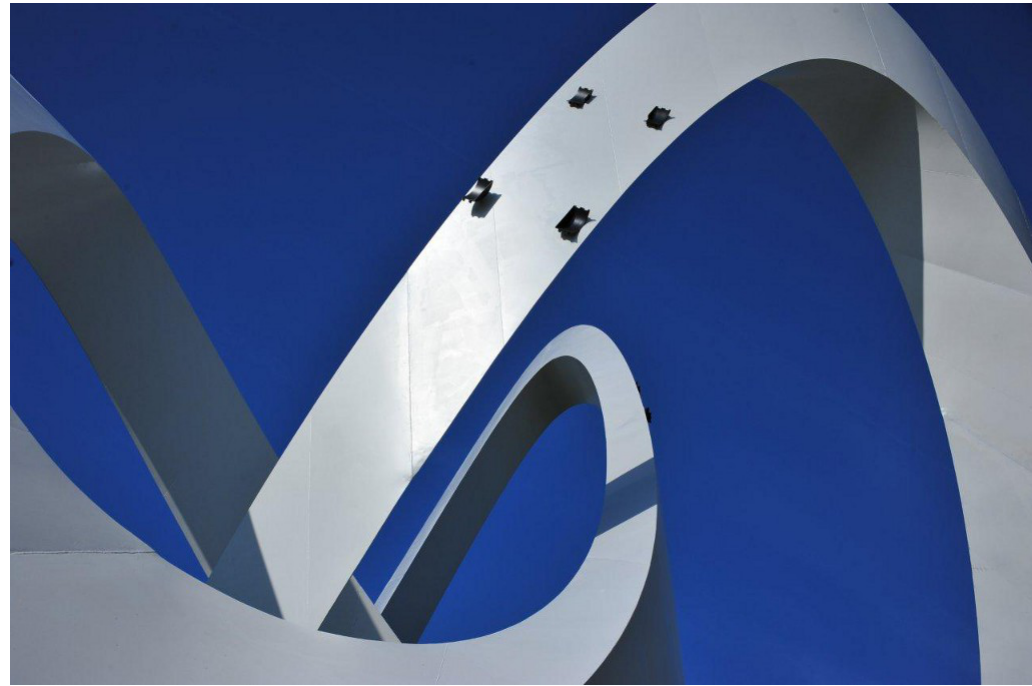
Figure 29. Final shape. The black attachments are mounting points for the wheels of a display car. Photo by S.